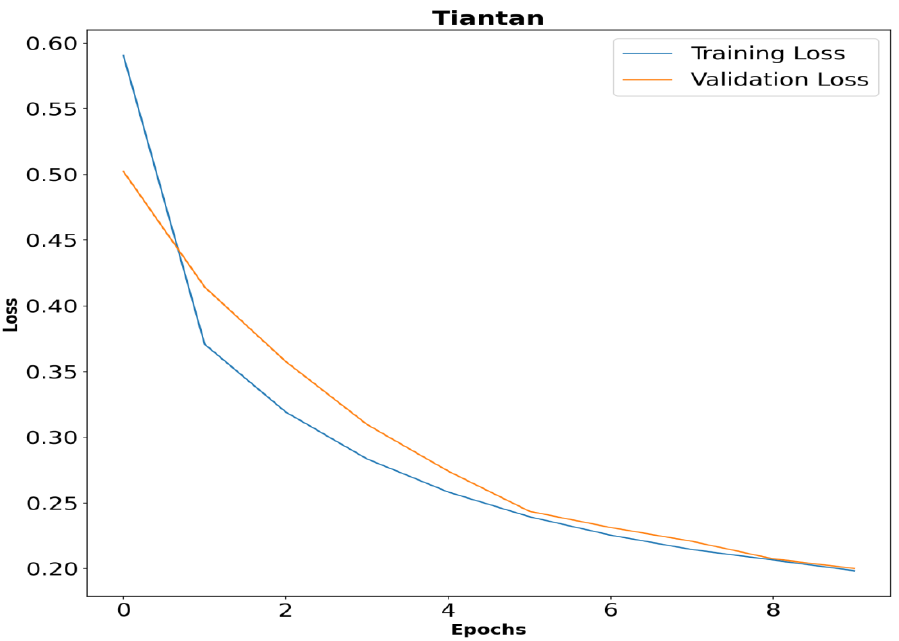
Figure 4. Graphs showing MAE values for all experimentations.